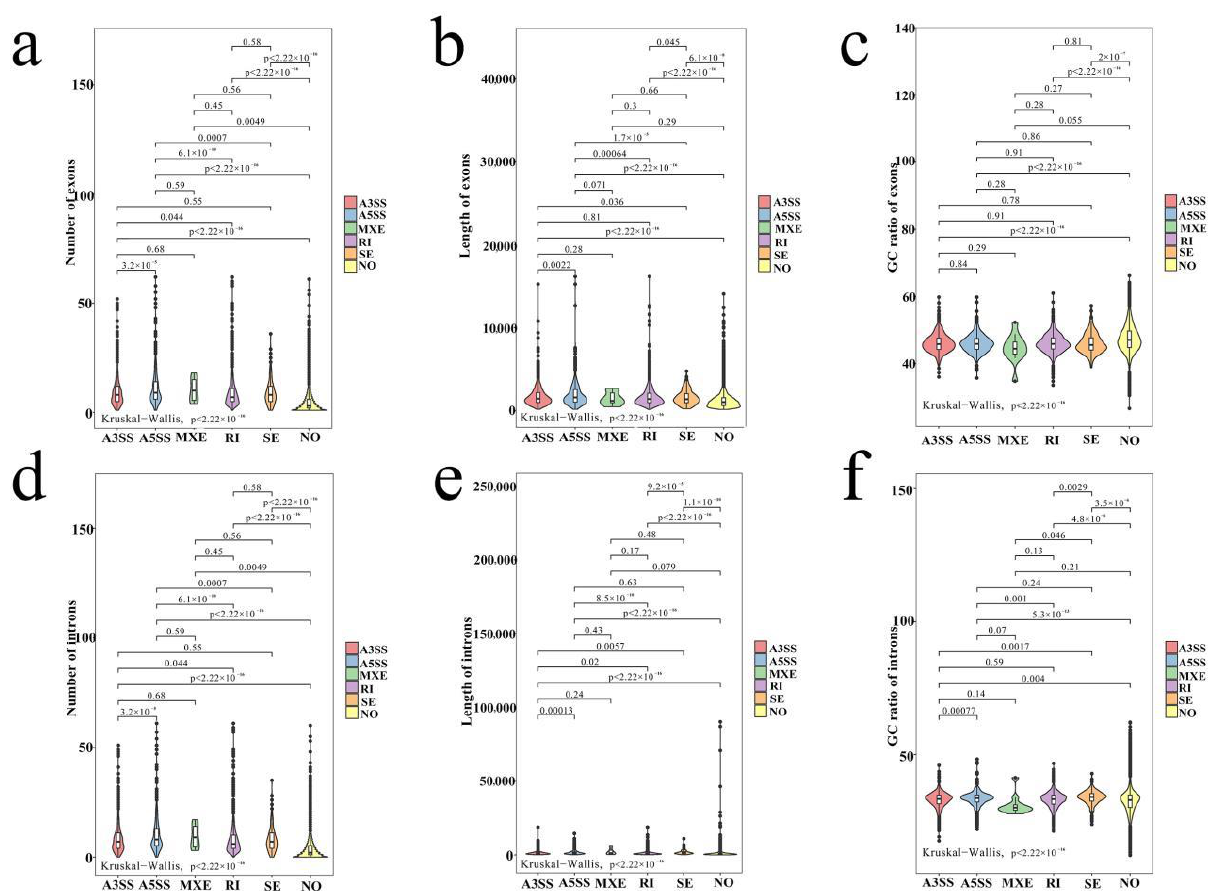
Figure 3. The structure of genes with A3SS, A5SS, MXE, IR, SE, and non-AS events. ( a ) The exon number of genes with A3SS, A5SS, IR, SE, and non-AS events. ( b ) The exon length of genes with A3SS, A5SS, IR, SE, and non-AS events. ( c ) The exon GC content of genes with A3SS, A5SS, IR, SE, and non-AS events. ( d ) The GC content of genes with A3SS, A5SS, IR, SE, and non-AS events. ( e ) The intron number of genes with A3SS, A5SS, RI, SE, and non-AS events. ( f ) The intron length of genes with A3SS, A5SS, RI, SE, and non-AS events.